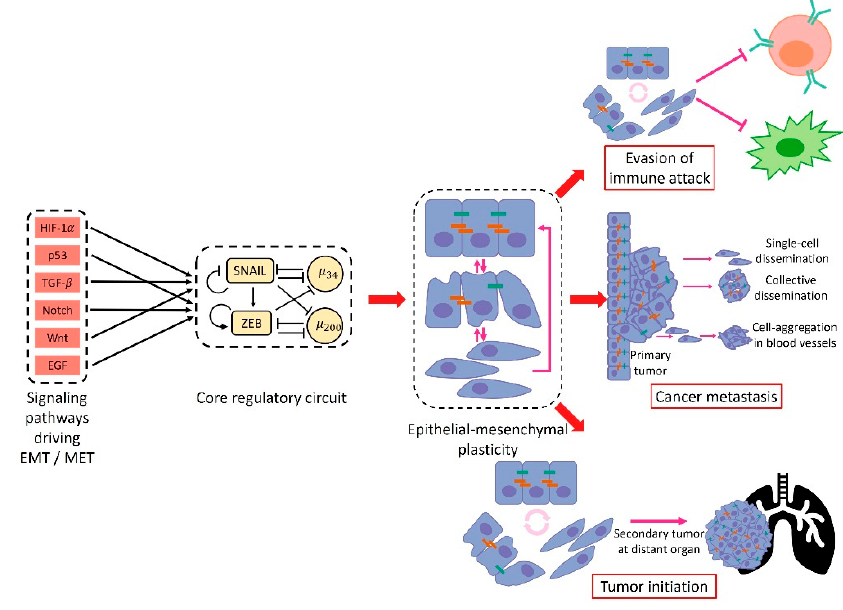
Figure 1. An overview of epithelial–mesenchymal plasticity causes and consequences. Multiple signaling pathways such as TGF- β , HIF-1 α and Notch have been implicated in driving epithelial–mesenchymal transition (EMT). All these pathways tend to converge to a core regulatory circuit which includes two EMT-inducing transcription factors (EMT-TFs), SNAIL and ZEB, and two microRNAs, miR-34 and miR-200. The core regulatory circuit exhibits multi-stable dynamics: multiple stable steady states for the same level of EMT-inducing signal. These stable steady states contain di ff erent levels of SNAIL / ZEB / miR-34 / miR-200 and thus corresponding to di ff erent EMT-associated phenotypes. The multi-stable dynamics of the core regulatory circuit allow for transitions among di ff erent stable states which leads to epithelial–mesenchymal plasticity. Cancer epithelial–mesenchymal plasticity typically enhances metastasis, allowing for disparate forms of migration and dissemination. In addition, epithelial–mesenchymal plasticity has been implicated in the acquisition of stem cell-like properties and immune evasion.